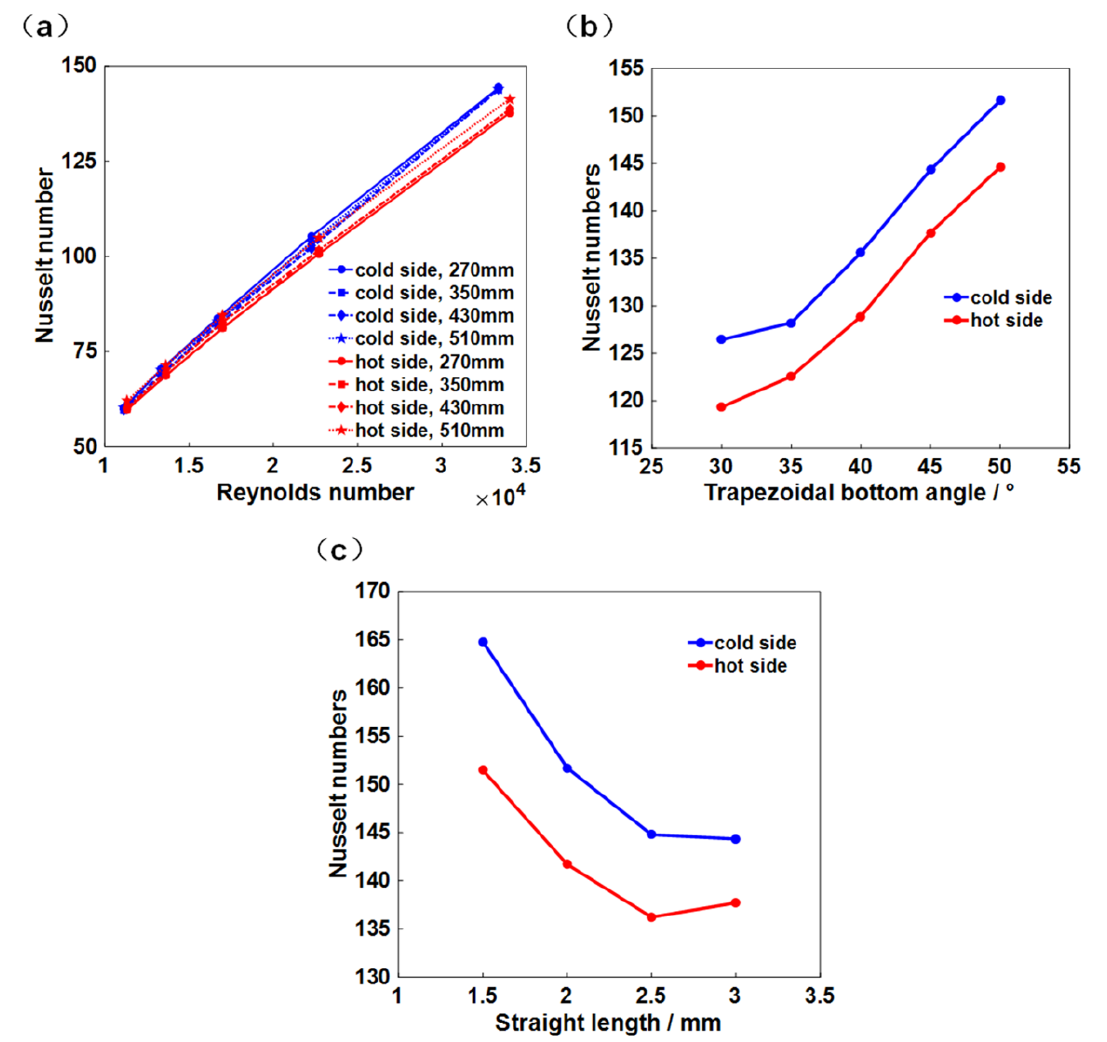
Figure 3. Effects of ( a ) the Reynolds numbers, ( b ) the trapezoidal bottom angle, and ( c ) the straight length on the Nusselt numbers.